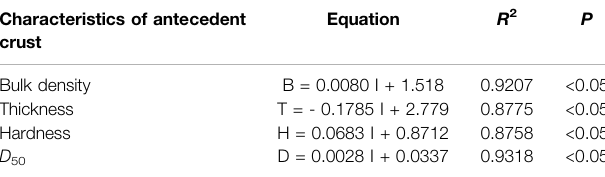
TABLE 2 | Relationships of crust characteristics with antecedent rainfall